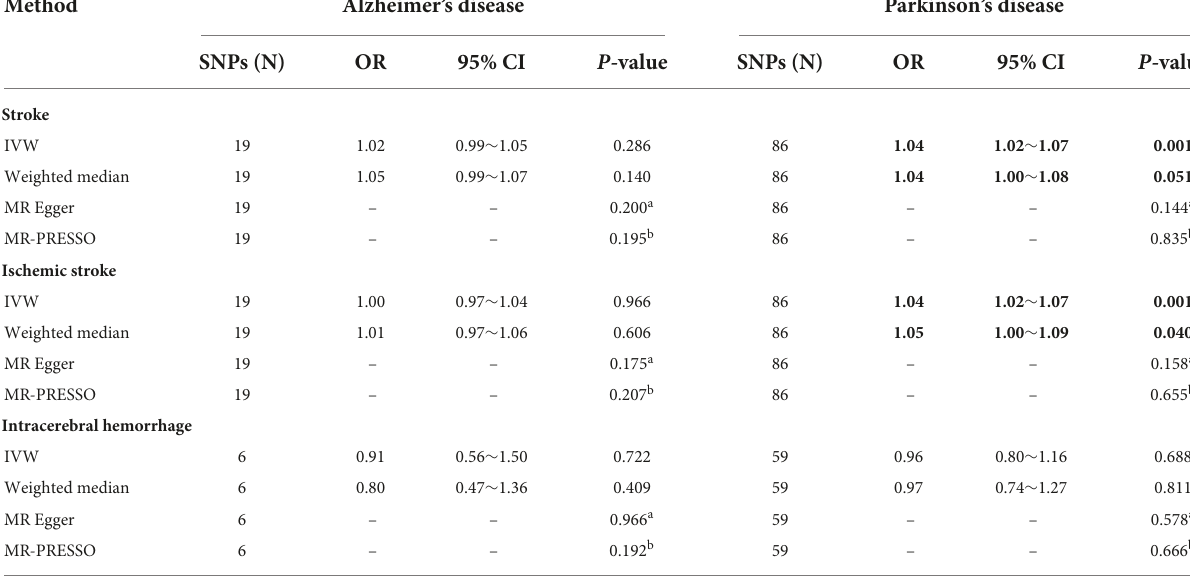
TABLE 1 Mendelian randomization analysis results for the causal associations of two common neurodegenerative diseases with stroke.